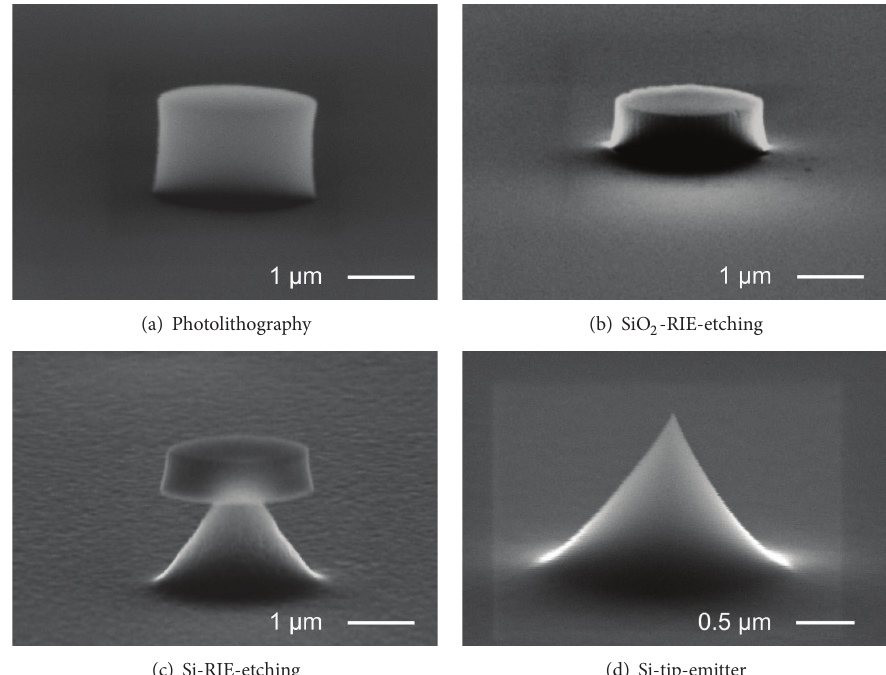
Figure 3: SEM images of the structured cathode fabrication process. (a) Developed photoresist. (b) Patterned SiO 2 disks. (c) Etched bulk Si. (d) Final emitter.